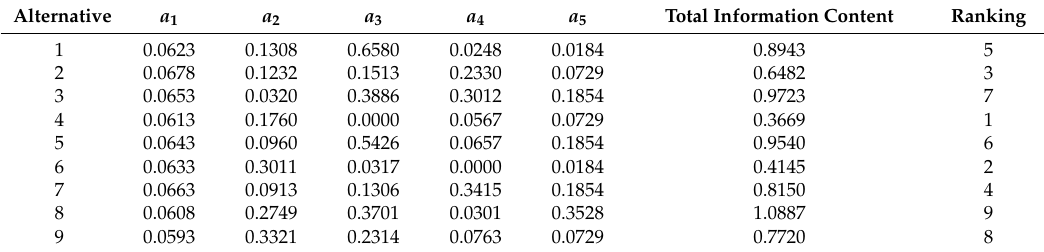
Table 8. Ranking of the nine alternative structural configurations obtained by heterogeneous axiomatic design